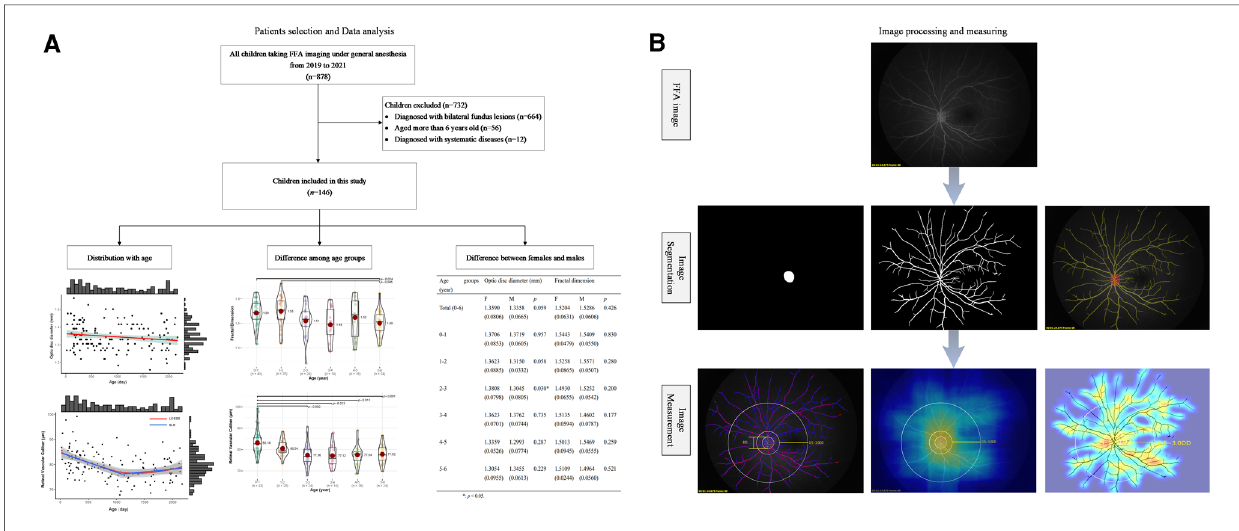
FIGURE 1 The framework of the study design. ( A ) Flowchart of recruited children from 2019 to 2021 and data analysis in this study, including the distribution of optic disc diameter and retinal vascular parameters (fractal dimension, caliber, density, and curvature of retinal vessels) with age, the difference of these indictors among several age groups, and difference of those indictors between females and males in each age group. ( B ) The presentation of image processing and measuring. Each FFA image was segmented to acquire the features of the optic disc and retinal vessels (image segmentation). Then, the optic disc diameter, fractal dimension of the whole retina, the mean caliber, density, and curvature of retinal vessels in the posterior retina were computed (image measurement). In the image measurement, the left picture showed the measurement of optic disc diameter and the caliber of retinal vessels, and each pink line represented the retinal vascular caliber at that special point; the medium picture showed the measurement of retinal vascular density, and the heat map present the value of density with the brighter color meaning the greater density; the right picture showed the measurement of retinal vascular curvature, and the heat map present the value of curvature with the brighter color meaning the greater curvature. FFA, fundus fl uorescein angiography.